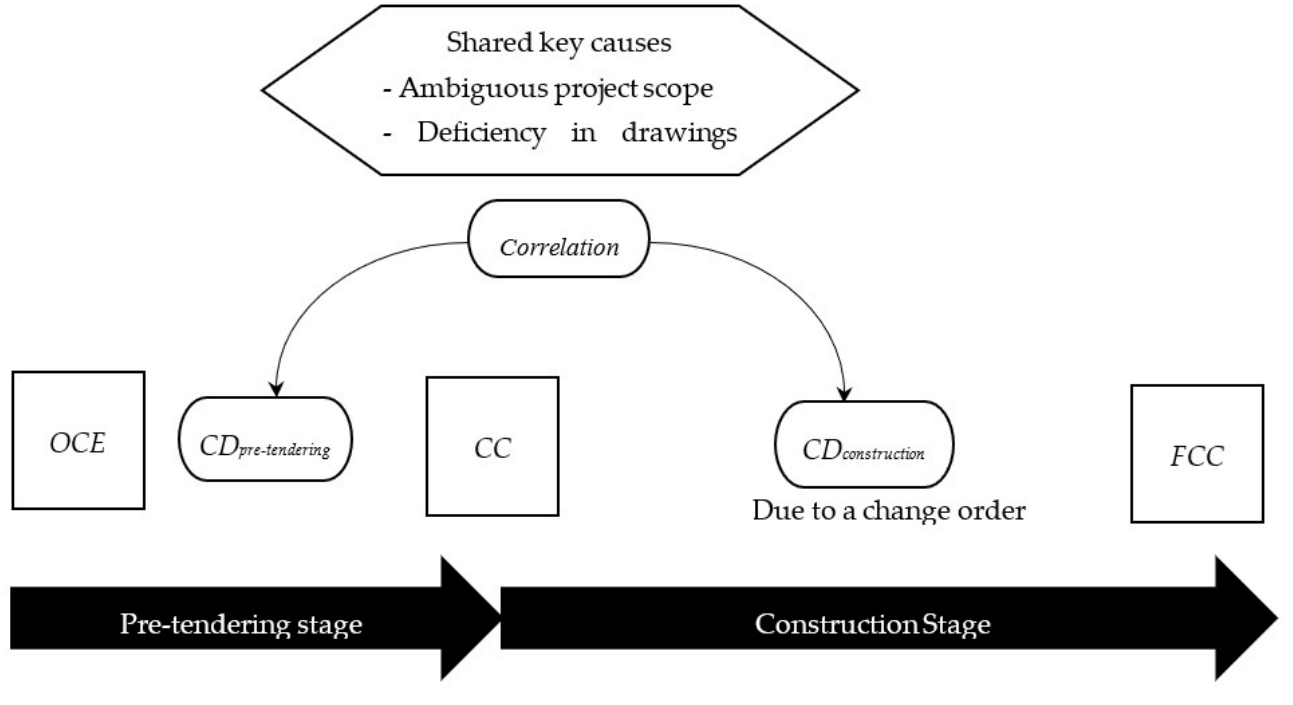
Figure 1. Problem of the